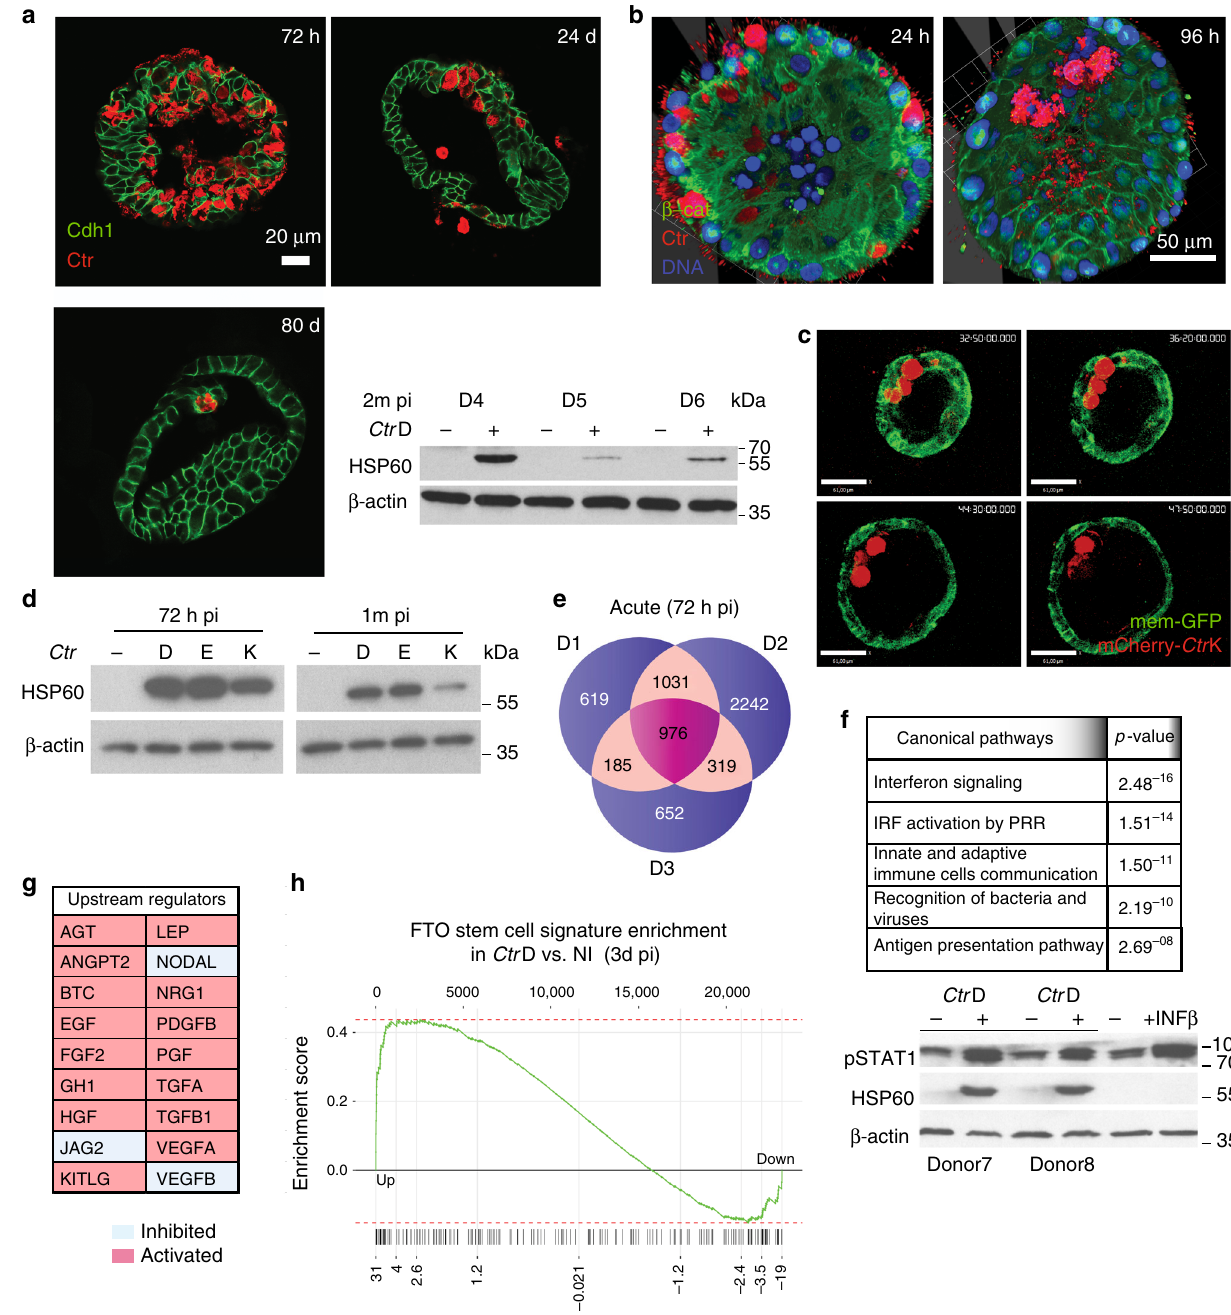
Fig. 1 Chronic Ctr infection of hFT organoids is characterized by early activation of in fl ammatory and paracrine signaling responses. a Representative confocal images of organoids infected with CtrD at 3, 24, and 80 d p.i., showing continuing presence of bacterial inclusions (red) within epithelial host cells (green). Scale bar: 20 µ m. The WB of protein lysates from chronic infection at 2 months p.i. from three independent donors shows the presence of actively replicating bacteria (HSP60 protein). b Whole-mount 3D composite images of acute Ctr infection at 34 and 96h p.i. showing a change in the localization of the bacteria ( Ctr , red) from the inclusions within the primarily infected host cells (left panel) to the lumen of the organoid (right panel) ( β -catenin, green). Scale bar: 50 µ m. c Still images as a time course from Supplementary Movie 1 demonstrate stepwise extrusion of bacterial inclusions to the lumen. Scale bar: 60 µ m. d Different genital Ctr serovars D, K, and E establish chronic infection in the organoids and maintain growth at 1 month p.i., as shown in the WB of the protein lysates harvested at acute and chronic phase. e Venn diagram showing extensive overlap between three different donors in the genes differentially expressed in response to Ctr infection, as detected by microarray analysis at 72h p.i., with 976 genes regulated in all samples. f Ingenuity pathway analysis, suggesting strong activation of pro-in fl ammatory signaling, in particular interferon- β , which was independently con fi rmed by WB and detection of phospho STAT1 in infected samples with interferon- β treated organoids as positive control. g Table of activated paracrine pathways in the acute Ctr infection based on ingenuity upstream regulator analysis IPA. h GSEA analysis of fallopian tube (FT) organoid stem cell signature genes 13 compared to differential gene expression in infected vs. non-infected organoids at 3 d p.i. shows signi fi cant enrichment (ES = 0.44, p <0.001, permutation test using 5000 permutations) among upregulated